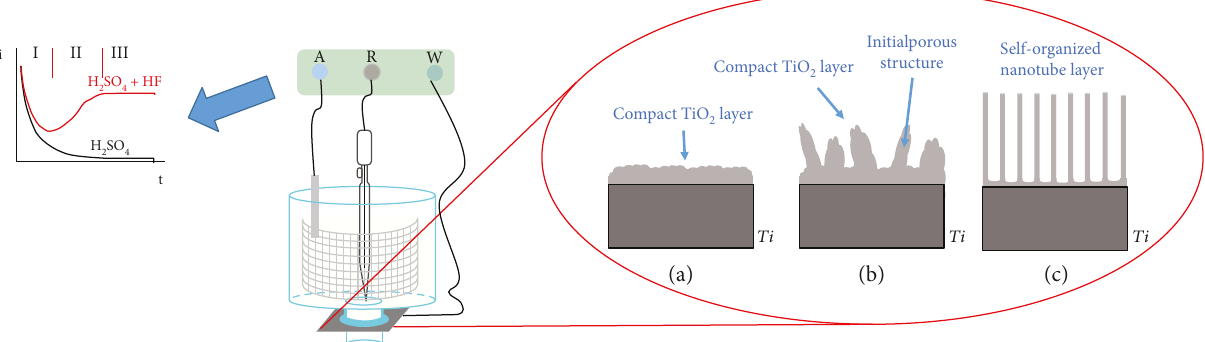
Figure 6: Key steps during the self-organized nanotube layer formation based on anodization process in fl uoride